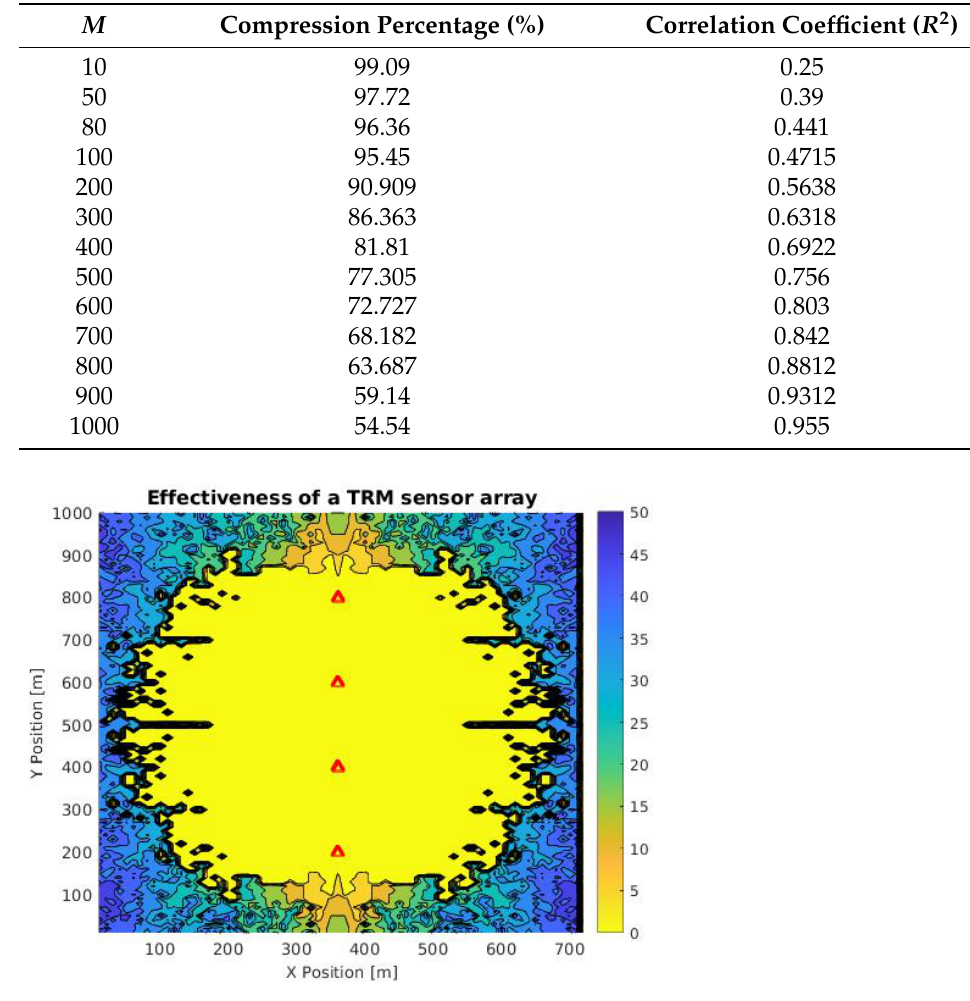
Figure 7. Contour plot of the accuracy in TRM array in an area of 0.72 km 2 for a landing ship signal. Red triangles are sensor positions and the color scale is a function of the difference between expected and calculated